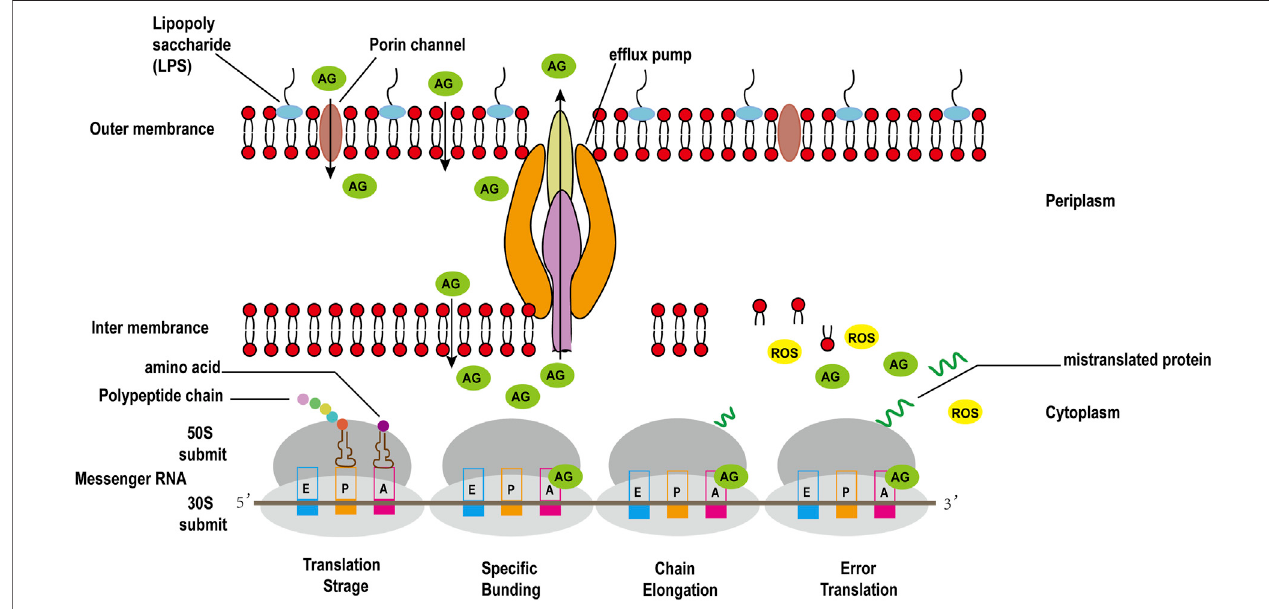
FIGURE 3 | Antimicrobial mechanisms of aminoglycoside antibiotics in gram-negative